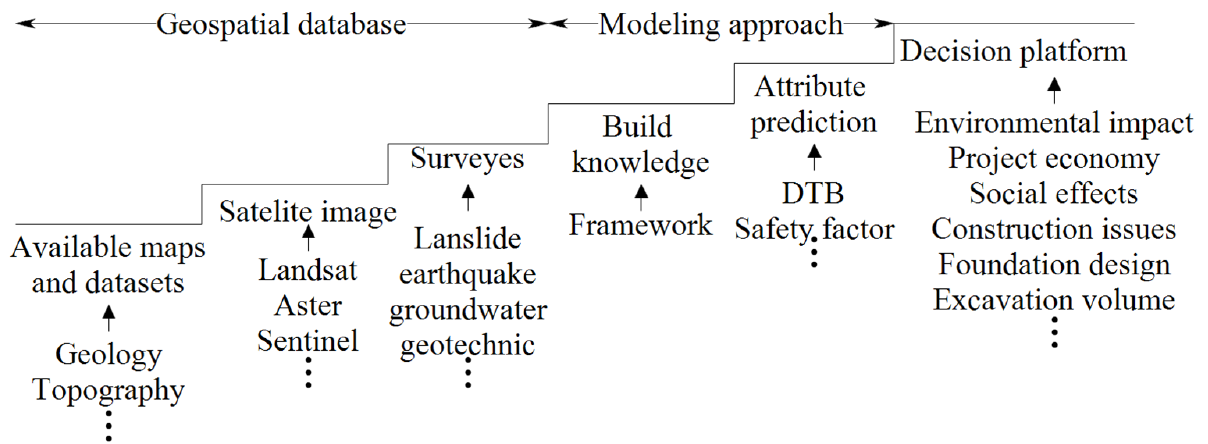
Figure 1. Toward decision platform using geospatial database.